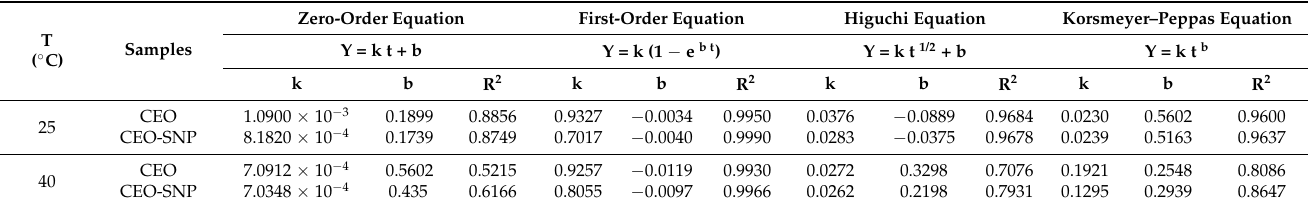
Table 2. The Fitting Kinetic models for release behaviors of (a) CEO, (b) CEO-SNP.